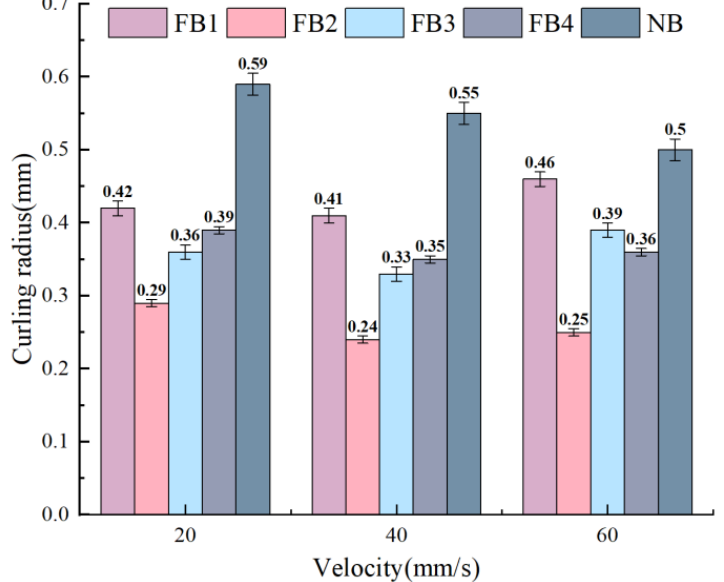
Figure 10. Chip curl radius of broaches with different surfaces.